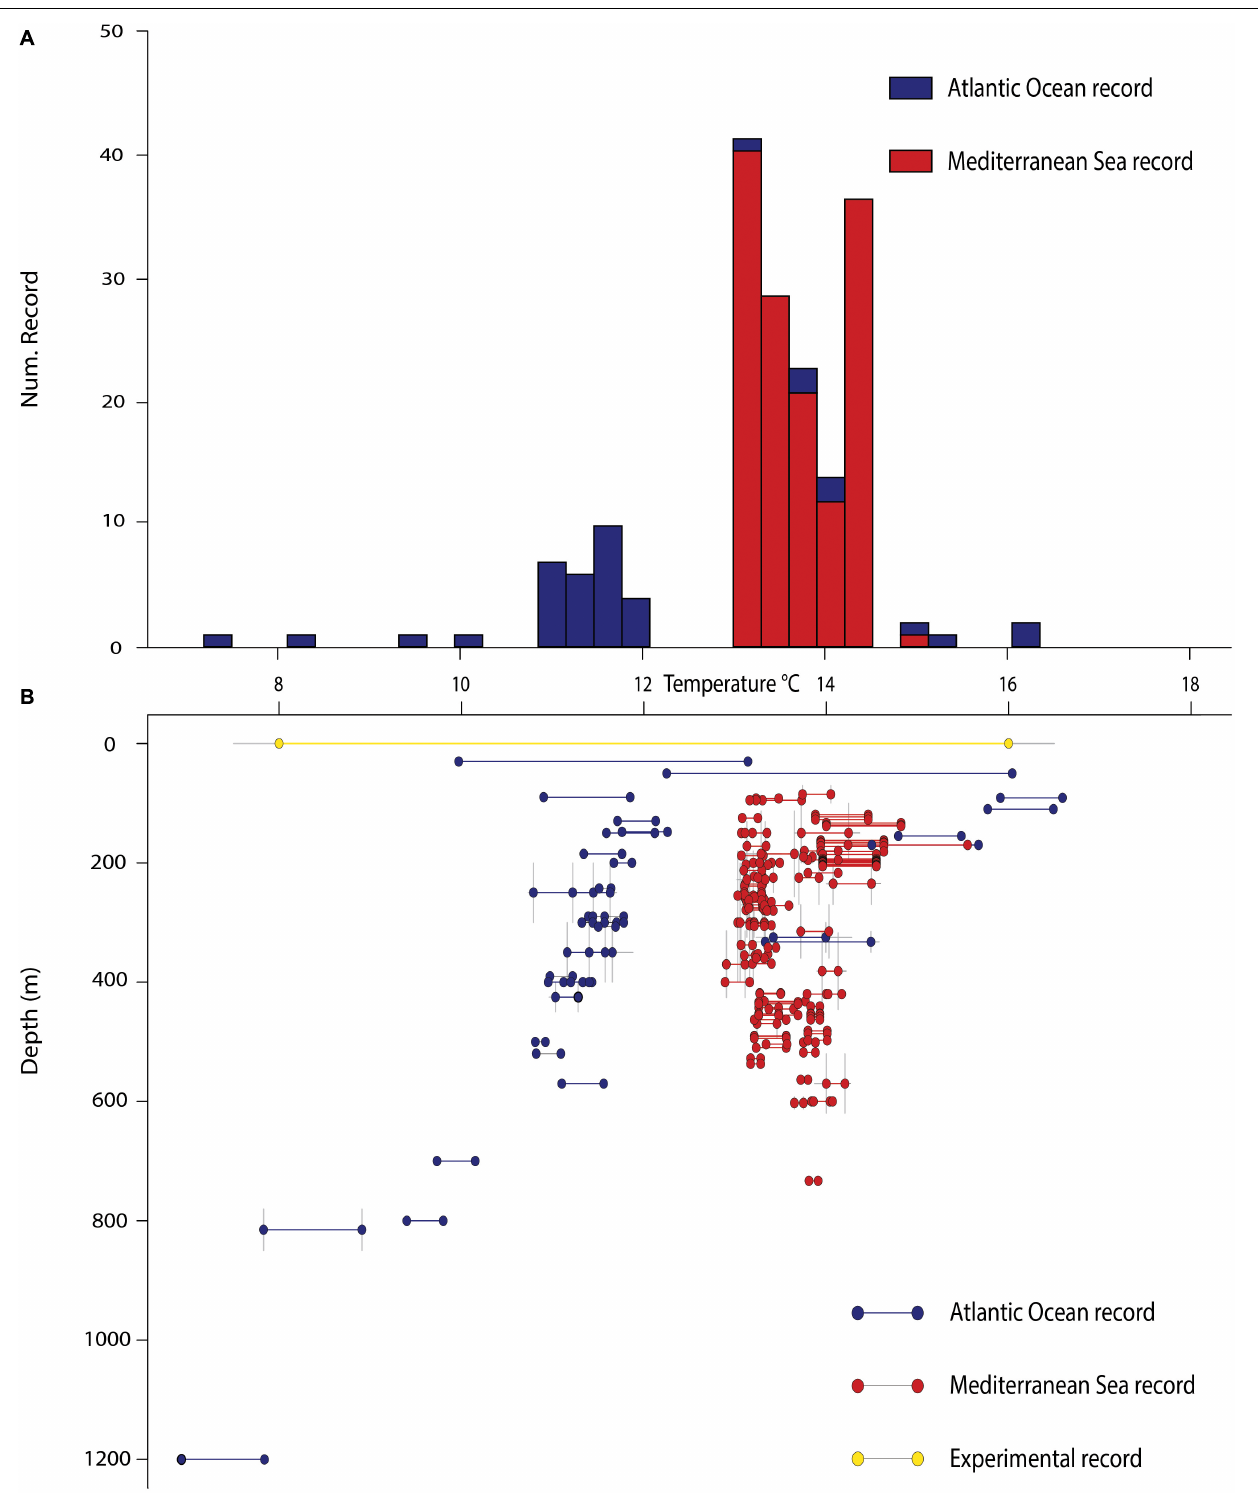
FIGURE 3 | Frequency histogram and temperature annual variability of D. cornigera sites by water depth. (A) Number of D. cornigera records by temperature. (B) Temperature variability ranges defined by annual minimum and maximum values for each D. cornigera site and related with water depth. Yellow bar represents the temperature interval observed from in-tank experiment (Gori et al., 2014); horizontal gray lines represent the uncertainty value related with temperature, while the vertical ones stand for those ralated with depth.